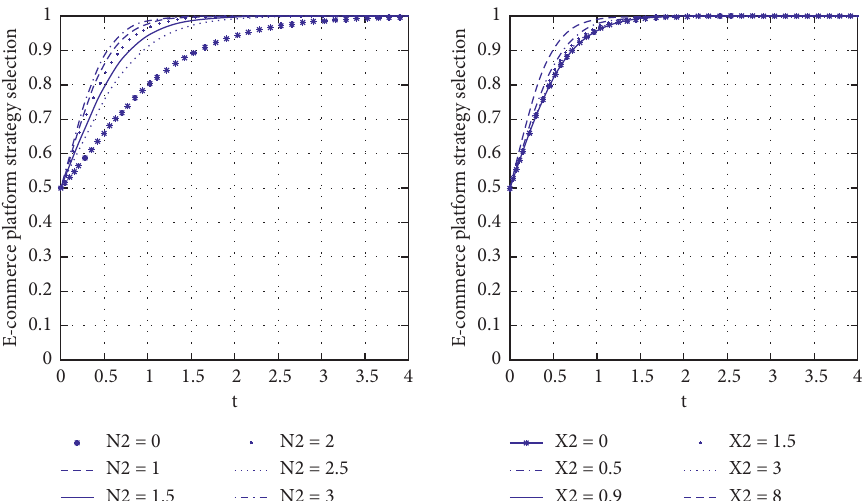
Figure 7: Influence of factors leading to the loss of e-commerce platform reputation on the choice of e-commerce platform